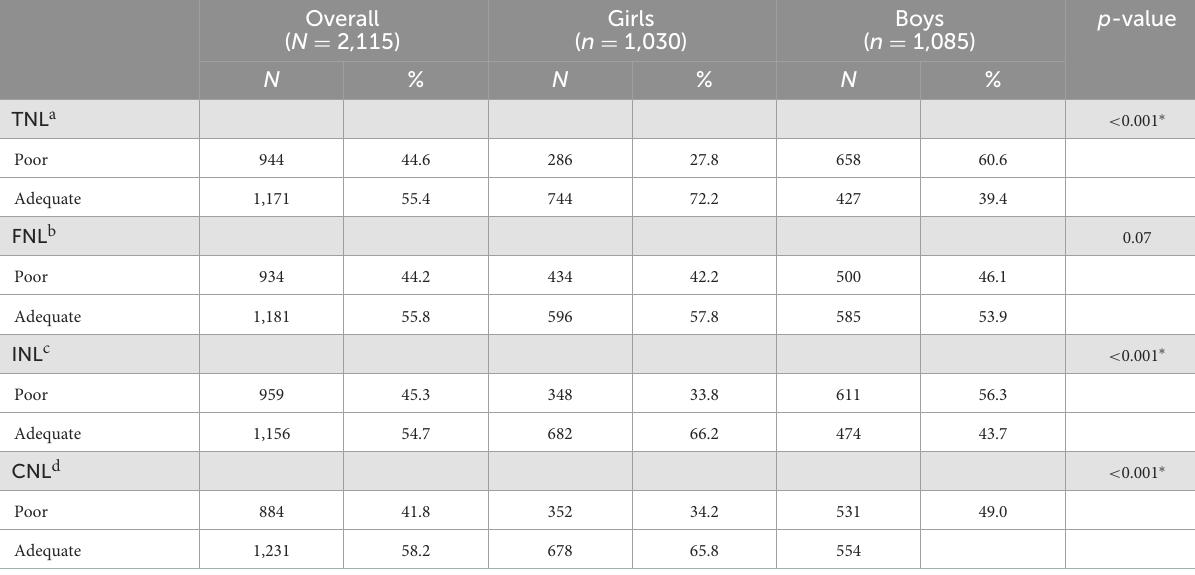
TABLE 3 The status of adolescents’ nutrition literacy, overall and by adolescents’